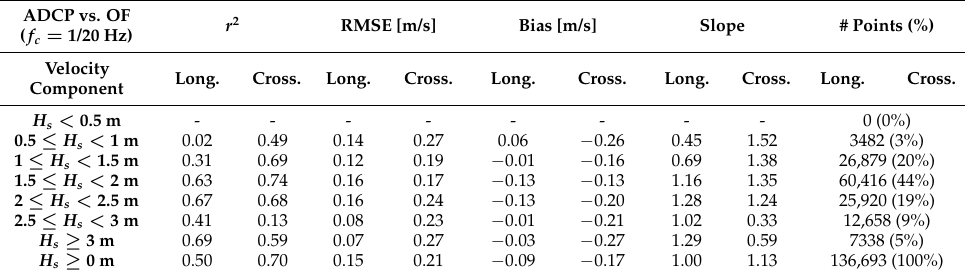
Figure 5. Five minute time-averaged ( a ) longshore and ( b ) cross-shore surface velocity components time series from 8 to 15 October 2018. ADCP surface velocity measurements (average between σ 19 , σ 20 and σ 21 ) are displayed with a purple line. Optical flow velocity estimates computed from low-pass filtered images with f c = 1/20 Hz and f c = 1/60 Hz are shown with an orange and a green line, respectively. Positive cross-shore (longshore) surface velocities values correspond to an offshore-directed (directed away from the headland) current. Non-shaded (blue shaded) regions indicate the time when the ADCP is located inside (outside) the surf zone. For better visualization, surface velocities are concatenated in time to avoid gaps during nightlight hours. Comparison between OF ( f c = 1/60 Hz) and ADCP surface velocities shows a smaller bias and less dispersion of the data with respect to OF ( f c = 1/20 Hz). Although r 2 suggests a similar linear agreement ( r 2 ≈ 0.5), optical flow velocities are overall smeared as shown in the histograms of Figure 6c,d. This is also evidenced by the steeper values of the regression slope (slope > 2). Table 2. Five minute time-averaged ADCP vs. optical flow surface velocity components from 8 to 15 October 2018 under different ranges of offshore significant wave height H s during low tide when the ADCP is located inside the surf zone. Optical flow velocities are computed from low-pass filtered images with f c = 1/20 Hz.